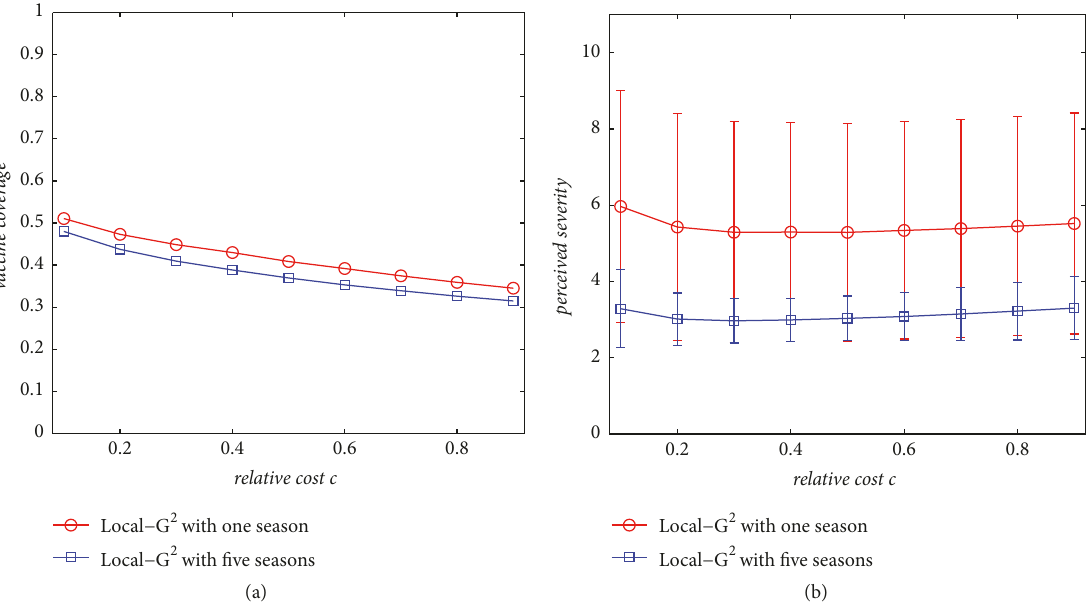
Figure 4: The average vaccine coverage and perceived epidemic severity under different values of relative cost. The red lines demonstrate the performance of the local - 𝐺 2 mechanism using only disease-related information of the past one season, and the blue lines demonstrate the performance of the local - 𝐺 2 mechanism using disease-related information of the past five seasons. The simulations are carried out in a scale-free network with network size 𝑁 = 10,000 and average degree ⟨𝑘⟩ = 4 . The results are based on the last 500 epidemic